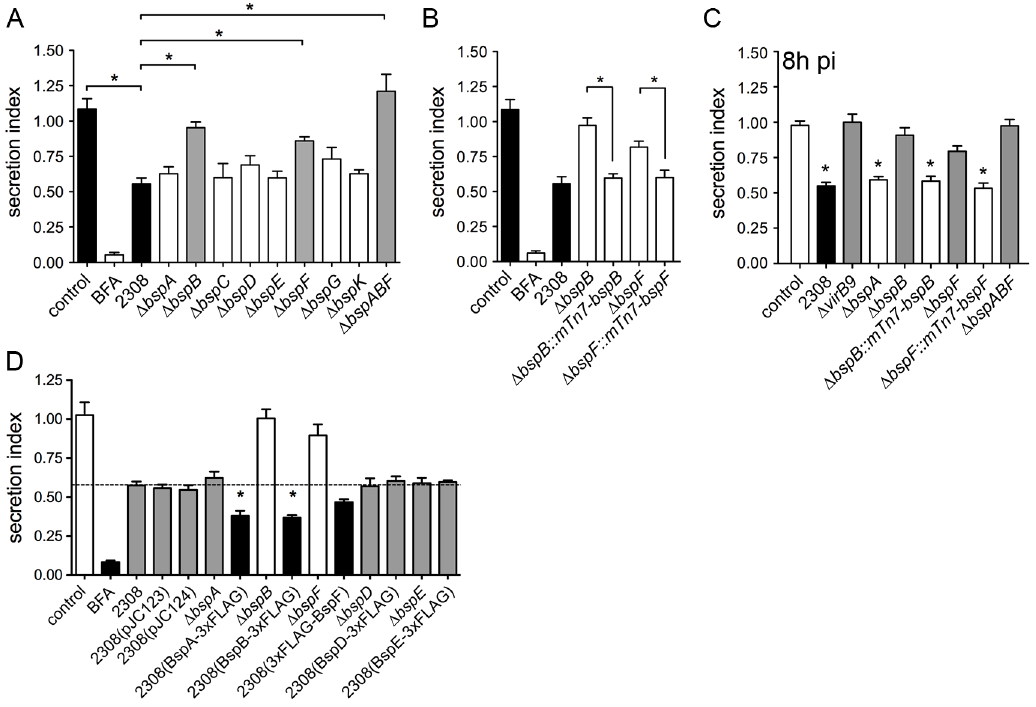
Figure 7. Contribution of BspA, BspB and BspF to inhibition of host cell secretion during infection. (A) SEAP secretion in HeLa cells infected with either wild type or bsp in-frame deletion mutants. Brefeldin A (BFA) treatment (5 m g/ml) was used as a control for secretion inhibition. (B) SEAP secretion in HeLa cells infected with either B. abortus 2308, D bspB and D bspF or the chromosomally-complemented strains D bspB :: mTn7- bspB or D bspF :: mTn7-bspF . (C) SEAP secretion in HeLa cells infected with either B. abortus 2308, D virB9 , D bspA , D bspB , D bspF , the chromosomally- complemented strains D bspB :: mTn7-bspB or D bspF :: mTn7-bspF or the D bspABF mutant. (D) SEAP secretion in HeLa cells infected with either B. abortus 2308, its isogenic D bspA , D bspB , D bspF , D bspD , D bspE mutants, or 2308 carrying pJC123, pJC124 or derivatives expressing FLAG-tagged BspA,